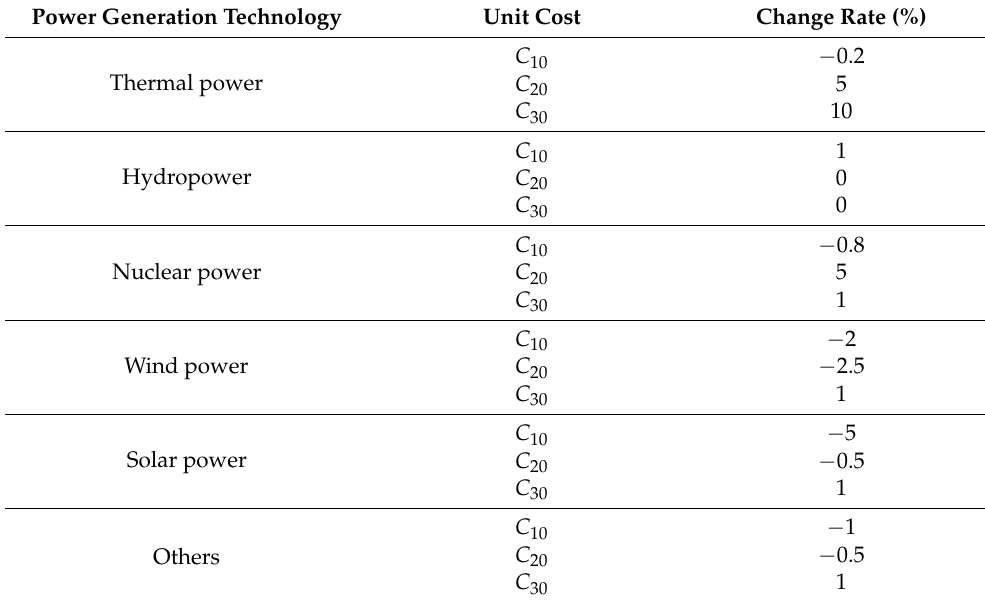
Table A1. Change rate settings of cost.